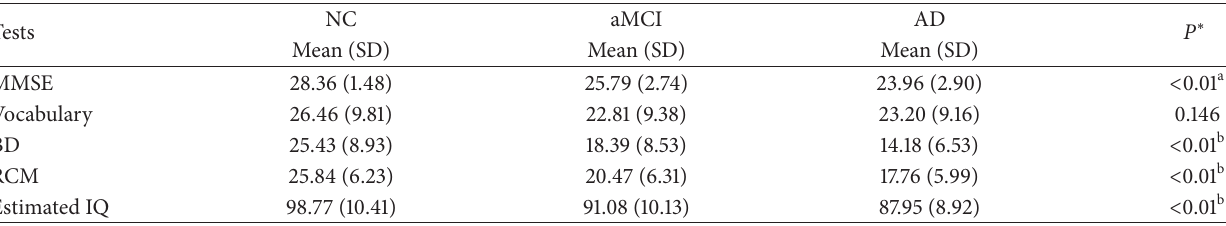
Table 2: Cognitive performance for NC, MCI, and